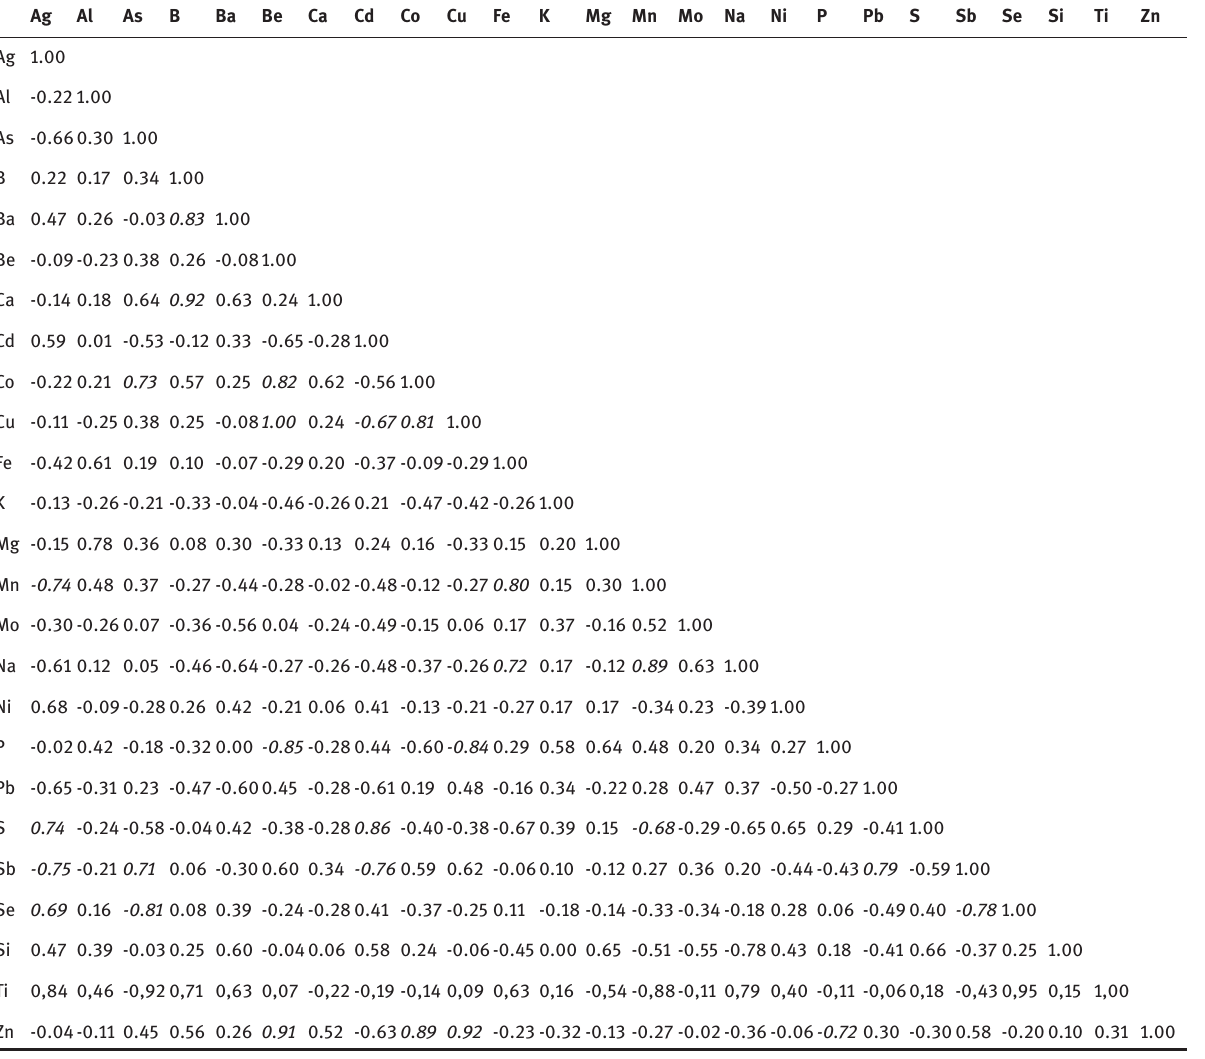
Table 5: Correlation matrix between elements in plant (N=12). italics – statistically significant differences Ag Al As